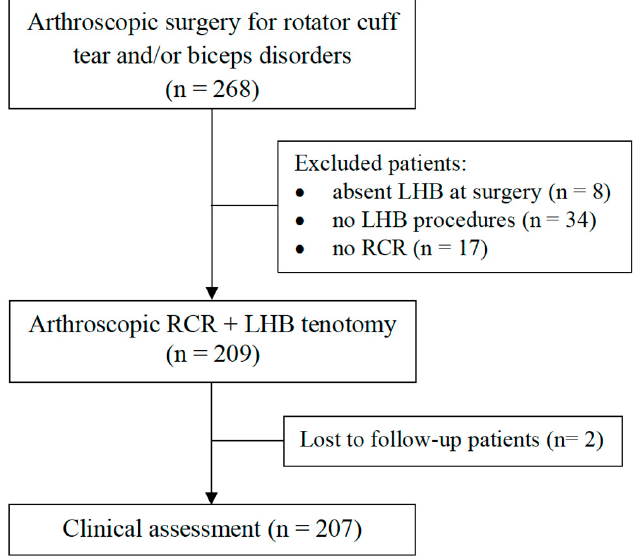
Figure 1. Flowchart. LHB, long head of the biceps; RCR, rotator cuff repair. Demographic data and clinical results are reported in Table 1. Table 1. Demographic data.